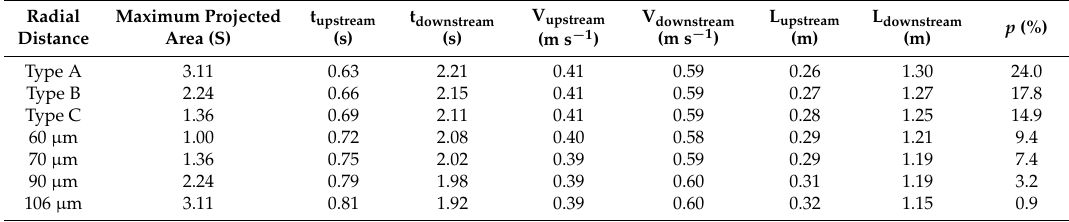
Table 7. Separation results of particles from the